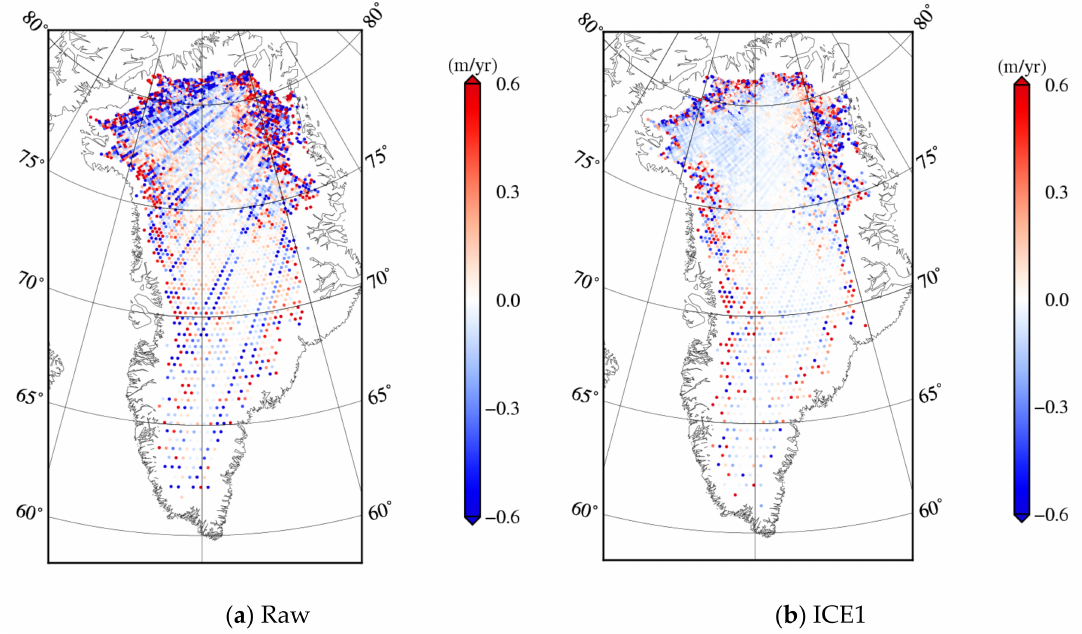
Figure 2. Elevation change differences in the crossovers of descending and ascending orbits from SARAL. ( a ) The differences of rate in the crossovers from SARAL without waveform retracking (raw). ( b ) The differences of rate in the crossovers from SARAL with the ICE1 retracker